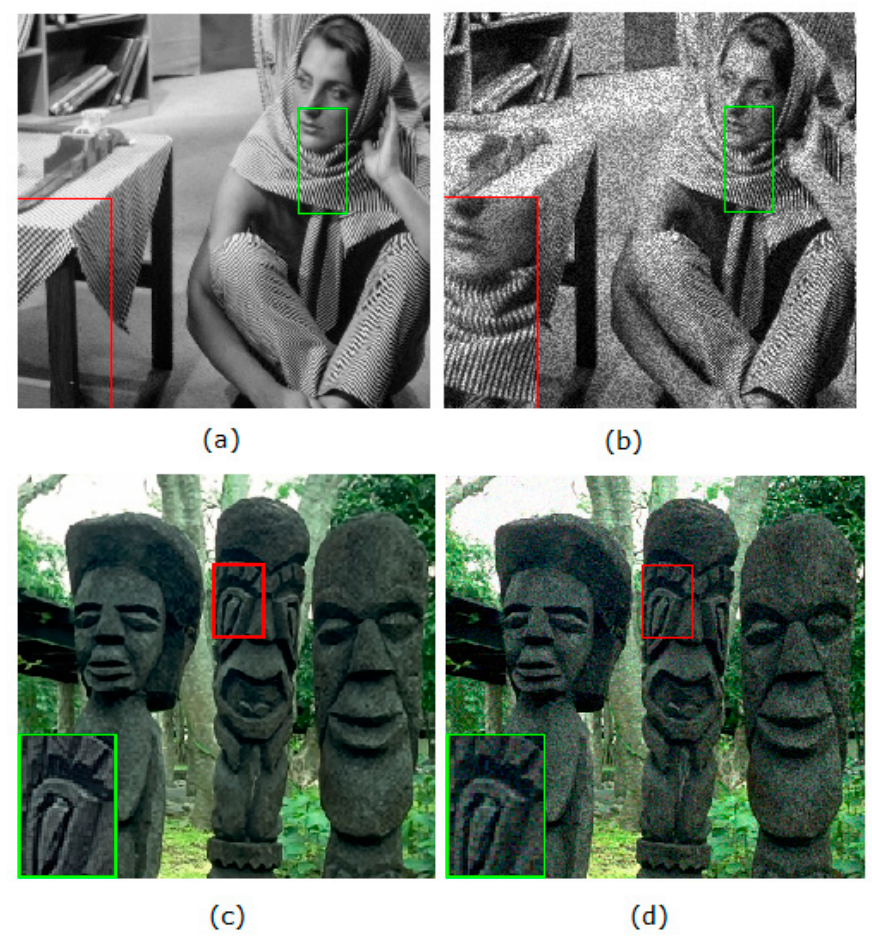
Figure 5. The clean images and the corresponding single-look speckle (𝜎 = 0.08) synthetic images. ( a ) Clean grayscale image ( b ) Speckled grayscale image (16.52 dB); ( c ) Clean color image; ( d )Speckled color image (17.89 dB).